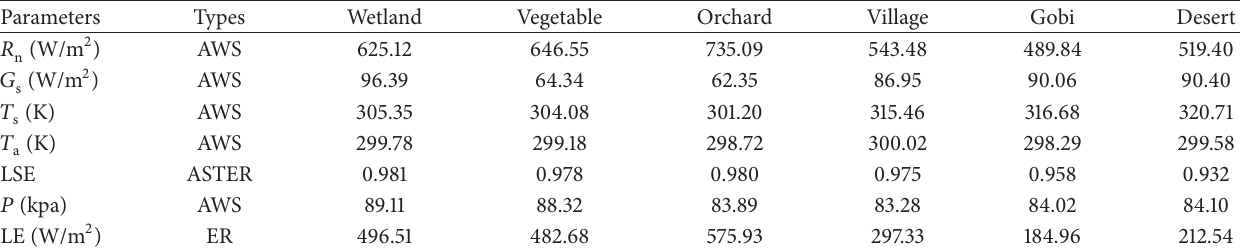
Table 3: Average of fluxes and environment parameters derived from AWS/ASTER at the six sites in the EC matrices, including net radiation ( 𝑅 n ), soil heat flux ( 𝐺 s ), land surface temperature ( 𝑇 s ), near-surface air temperature ( 𝑇 a ), land surface emissivity (LSE), near-surface pressure ( 𝑃 ), latent heat (LE), and sensible heat ( 𝐻 s ). The energy residual corrected (ER) LE is also revealed. Parameters Types Wetland Vegetable Orchard